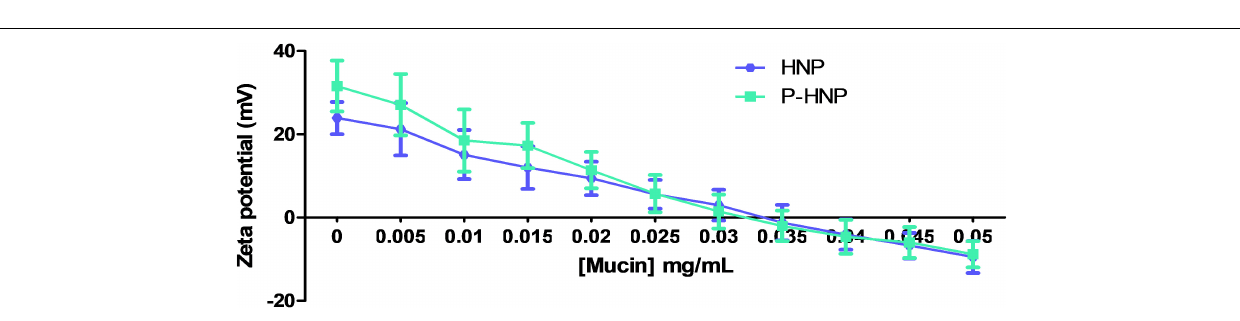
FIGURE 3 | Normalized absorption and emission spectra of free porphyrin ( P ), immobilized porphyrin ( P -chitosan and P-HNP ), and controls ( NP , chitosan, and HNP ). (A) Absorption spectra; (B) emission spectra, λ exc = 420 nm.